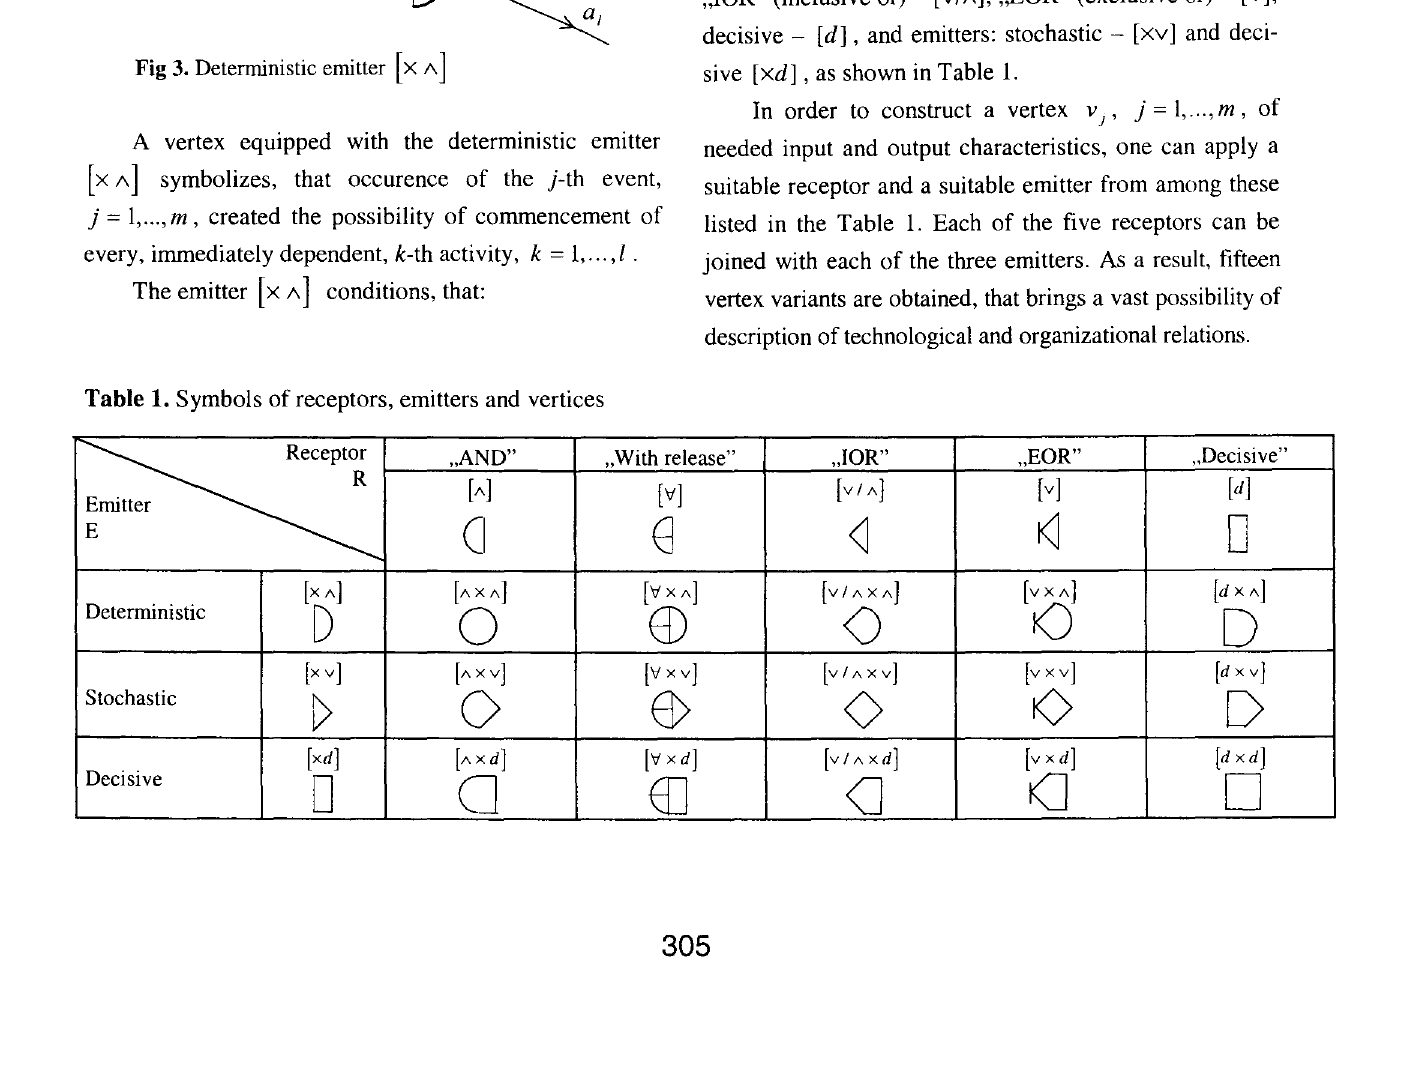
[X /\] Fig 3. Detenninistic emitter A vertex equipped with the deterministic emitter [ x 1\] symbolizes, that occurence of the j-th event, j = 1, ... , m , created the possibility of commencement of every, immediately dependent, k-th activity, k = l, ... ,l.